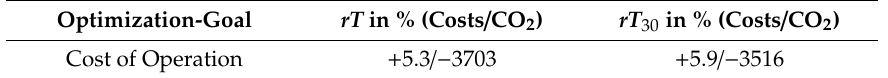
Table 4. Optimization results of scenario 2 in comparison to the results with standard controller.